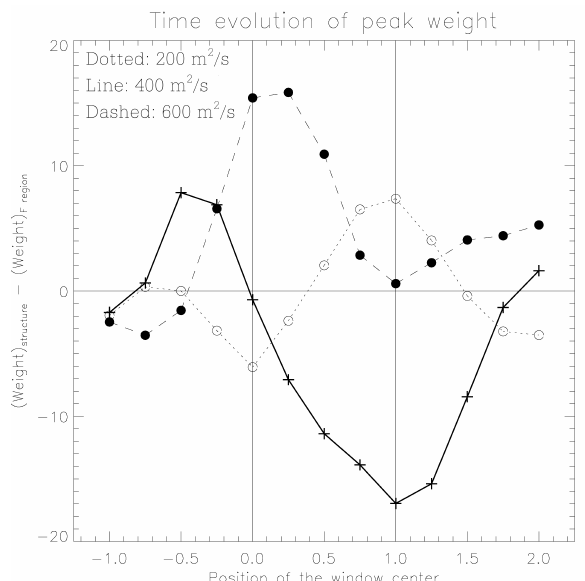
Fig. 8. Variation of the three classes of D in the course of the event. The high diffusive region (dashed line) appears before and seems to trigger the appearance of the structures. The F-region comes back to its average state (bold line) after the end of the event. During the event, it is characterized by a lower D value (dotted